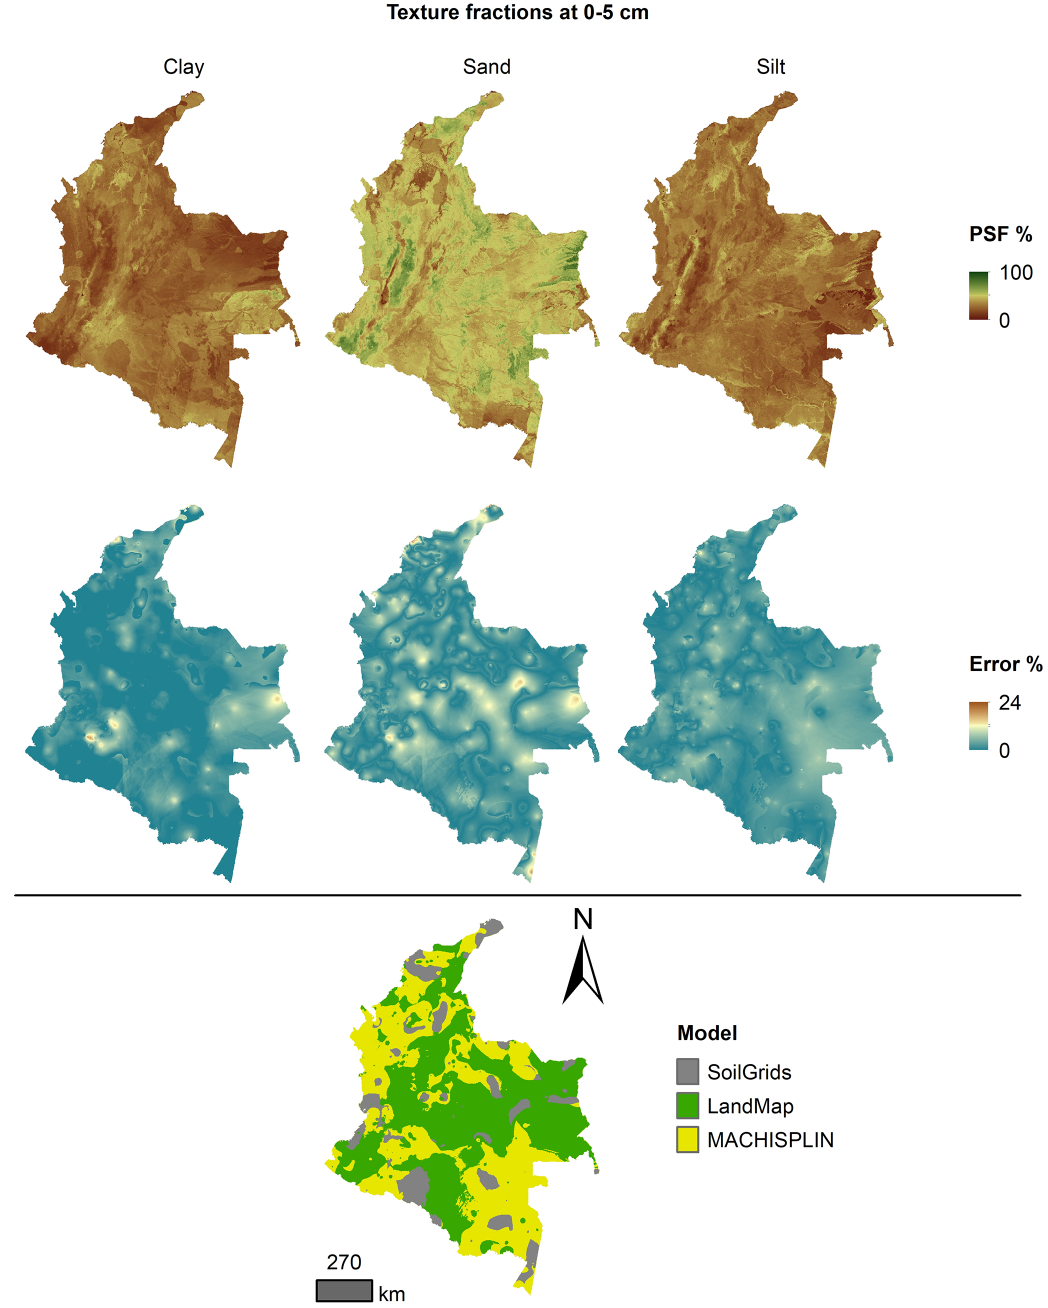
Figure 5. Ensemble model, percentage error distribution, and best model selected at 0–5cm.